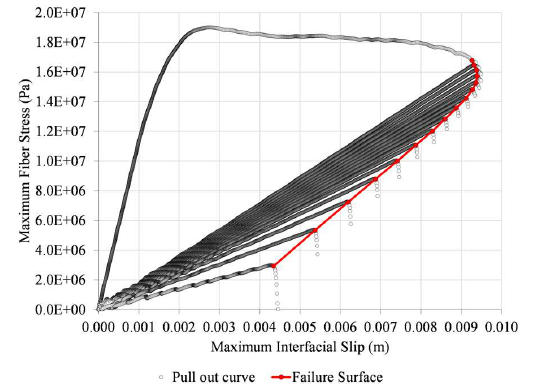
Figure 4. Full failure surface. The failure surface is defined as the minimum combination of interfacial stress slip and fibre stress which results in the remaining bonds accruing damage. It is apparent that the previous history of damage to the interface plays a role in the shape of the failure surface. Beyond a maximum interfacial slip, further damage to the interface occurs at reducing load and